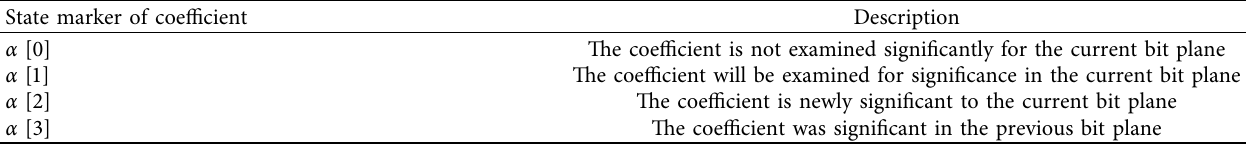
Table 1: Detail description of the state marker for coefcients “ α .”